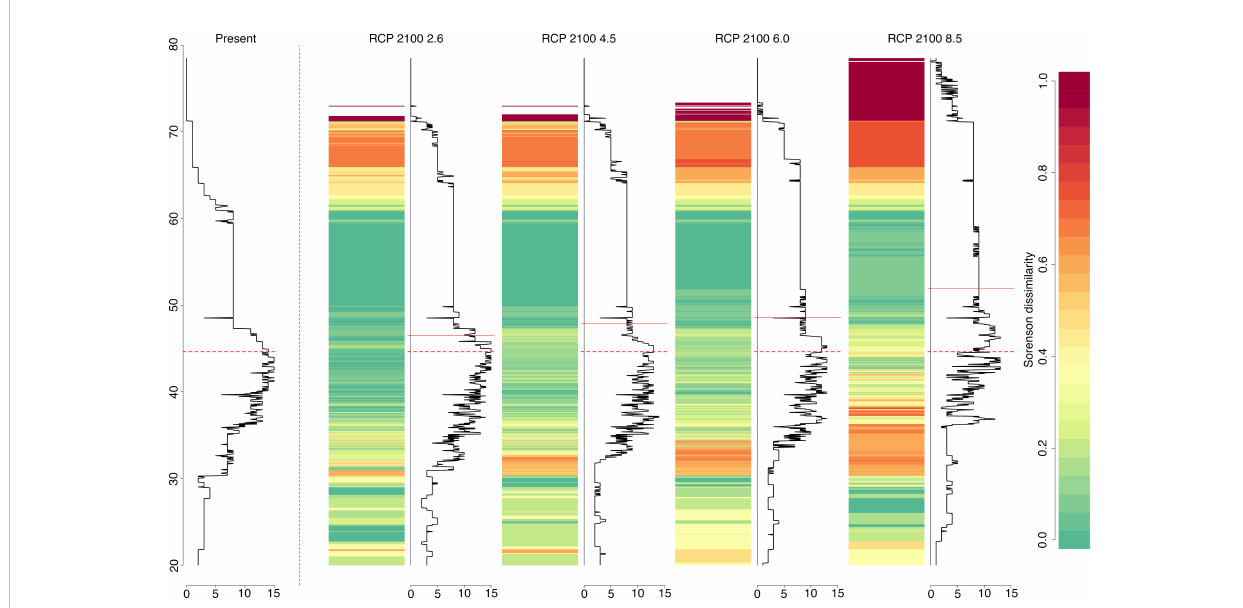
FIGURE 3 Latitudinal variation in alpha (species richness; solid black line graphs) and beta diversity (Sorensen dissimilarity index; coloured scale), for the present and the 2090-2100 time period, according to the four selected RCP scenarios. Dashed red lines indicate present latitudinal means weighted by species richness and solid red lines considers the same but for each RCP scenario.